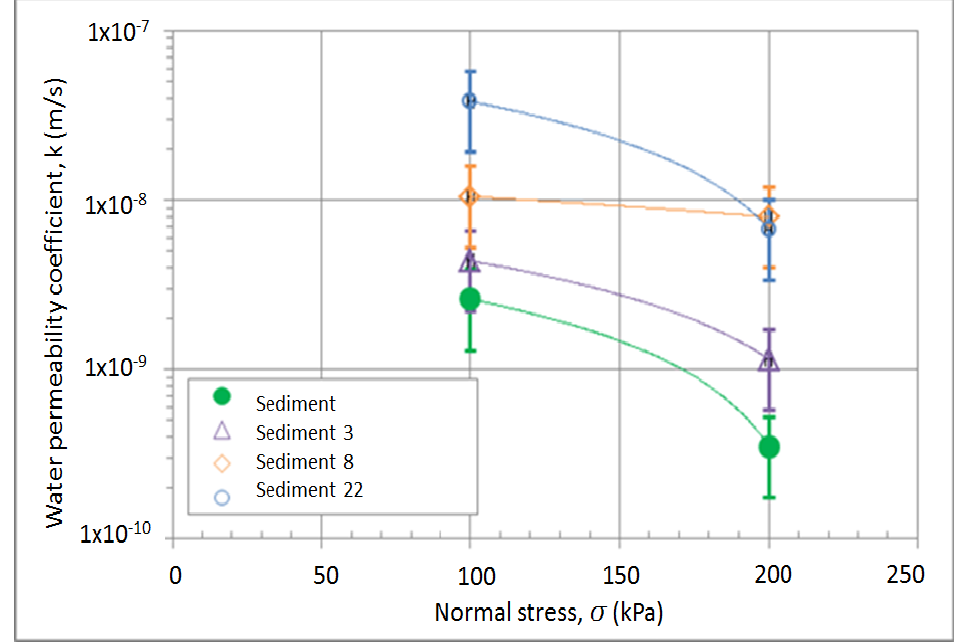
Figure 10. Results of water permeability coefficient of the mixtures; sediments only and sediments containing 3, 8, and 22% of lime additives.